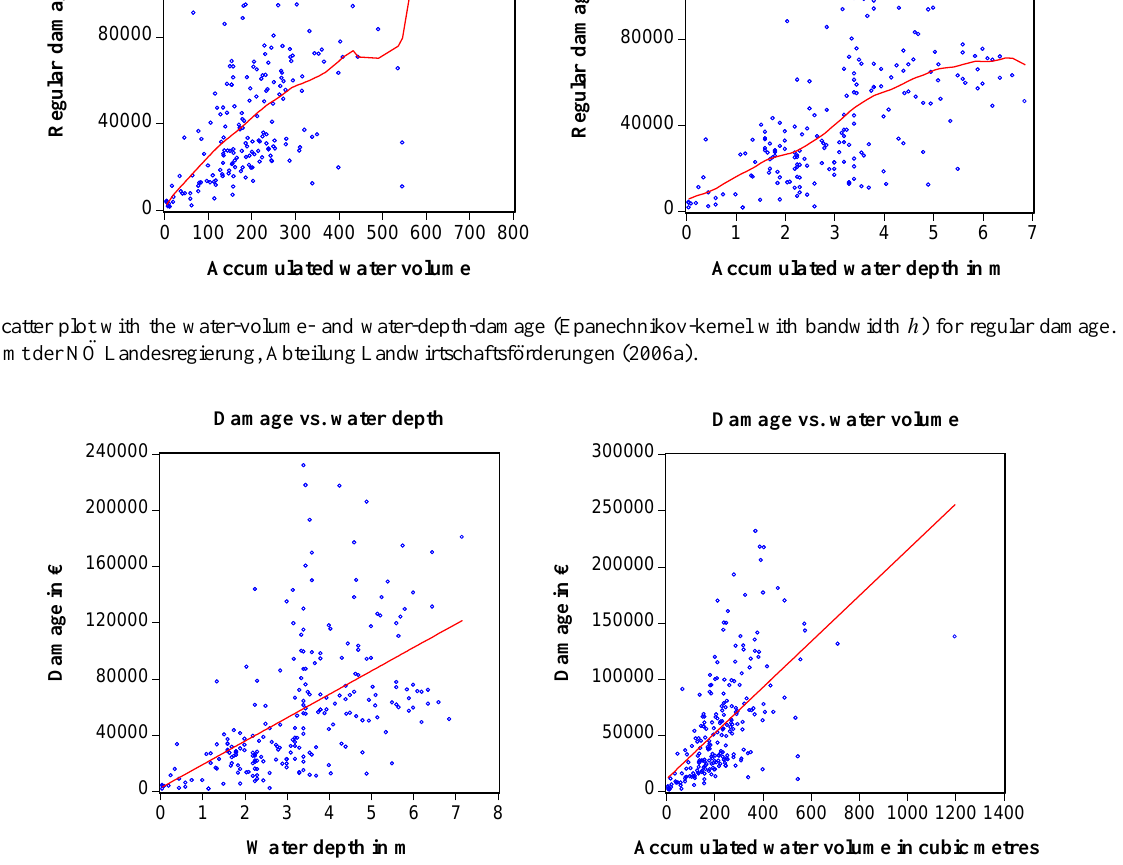
Fig. 5. Accumulated lin-lin-water-volume-damage curve and accumulated lin-lin-water-depth-damage curve (accumulated for all building